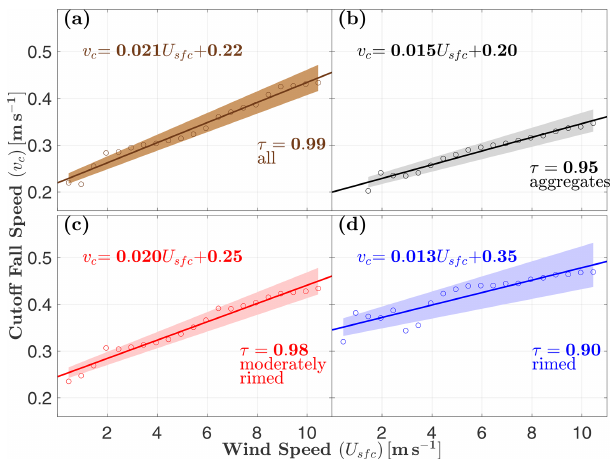
Figure 16. Cutoff MASC fall speed v c , defined in Sect. 2.2, as a function of surface wind speed U sfc for (a) all hydrometeor types, (b) aggregates, (c) moderately rimed, and (d) rimed. The solid line in each subplot is a linear least-squares best fit, while the shaded regions bound the 95% confidence interval. Goodness of fit is measured by applying the Kendall rank correlation coefficient τ = 2 (P − Q)/n(n − 1 ) (Kendall, 1938), where P is the number of concordant pairs, Q is the number of discordant pairs, and n is the total number of pairs. A value of τ = 0 indicates no relationship and 1 indicates a perfect relationship. The confidence interval represents the range of error for predicting a new value for v c . Only shielded MASC measurements are